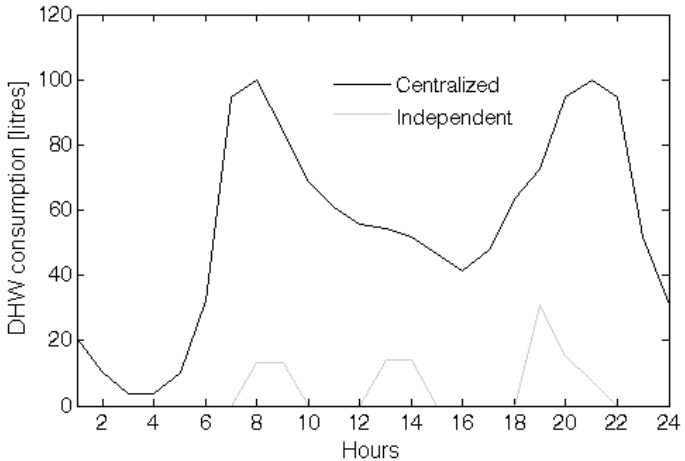
Figure 3. DHW load profile in different heating systems